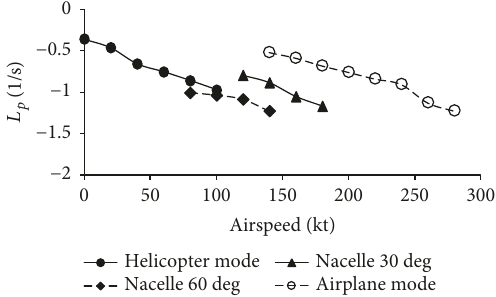
with forward speed. q